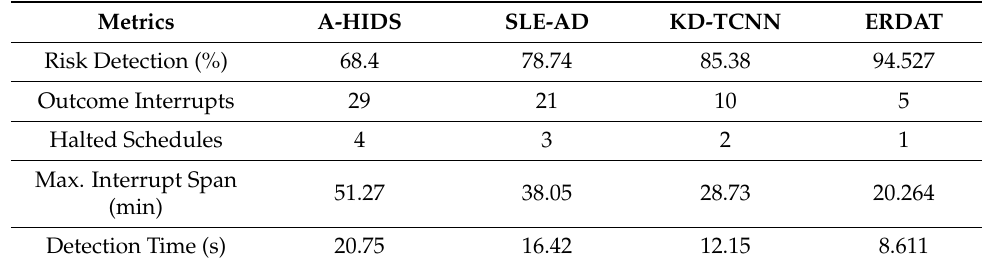
Figure 13. Detection Time. ( a ) Detection Time. ( b ) Interupts. Table 3. Comparative Analysis of Schedules.